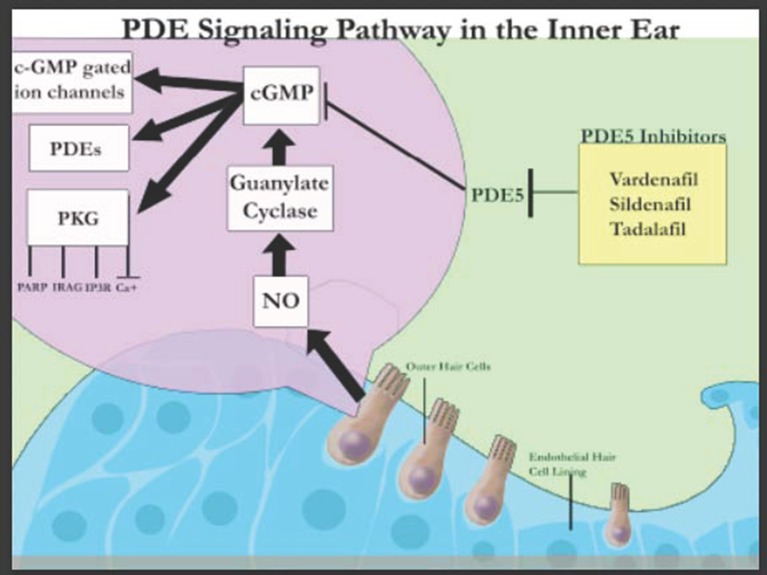
Schematic representation of PDE signaling in the inner ear (adapted from Layman and Zuo, 2012).